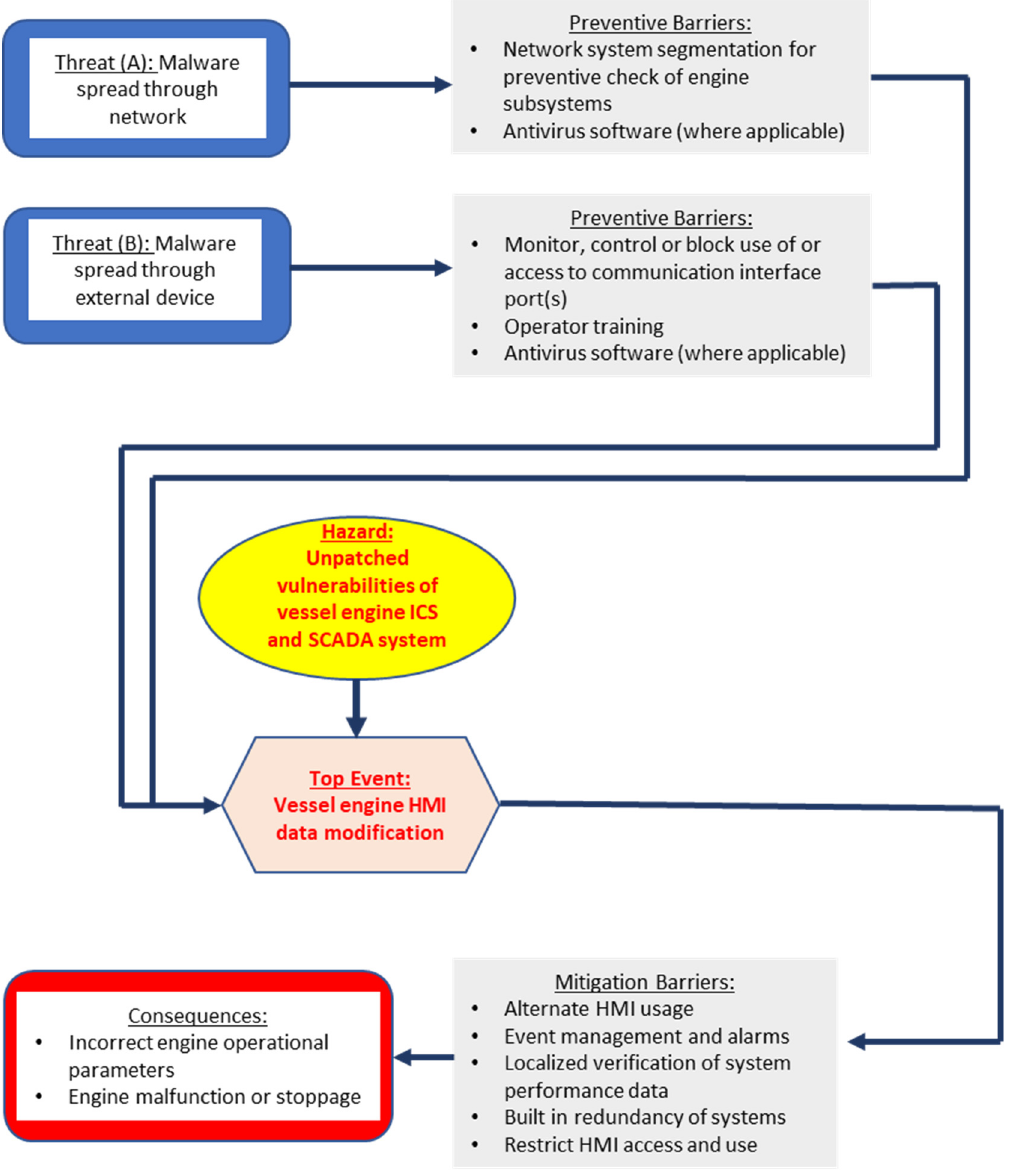
Figure 6. Bow Tie Analysis for vessel engine HMI data modification due to the fact of malware contamination.